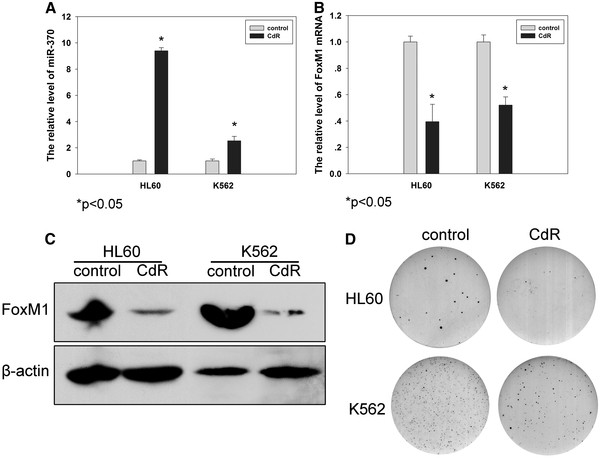
Expression of miR-370 in AML cells (HL60 and K562) and the effect of 5-aza-2’deoxycytidine (5-Aza-CdR). AML cells were plated in 6-well plates, treated with 5 μM 5-Aza-CdR or PBS and harvested after 72 hours. The expression of mature miR-370 was assessed using real-time PCR. (A) 5-aza-CdR increases the relative expression of miR-370 in AML cells. Data represent mean ± s.e. from three separate determinations. *p < 0.05 compared with respective controls. (B) 5-aza-CdR decreases the relative mRNA level of FoxM1 in AML cells. *p < 0.05. (C) 5-aza-CdR decreases the protein level of FoxM1 in AML cells. (D) Diminished foci formation of 5-aza-CdR treated AML cells